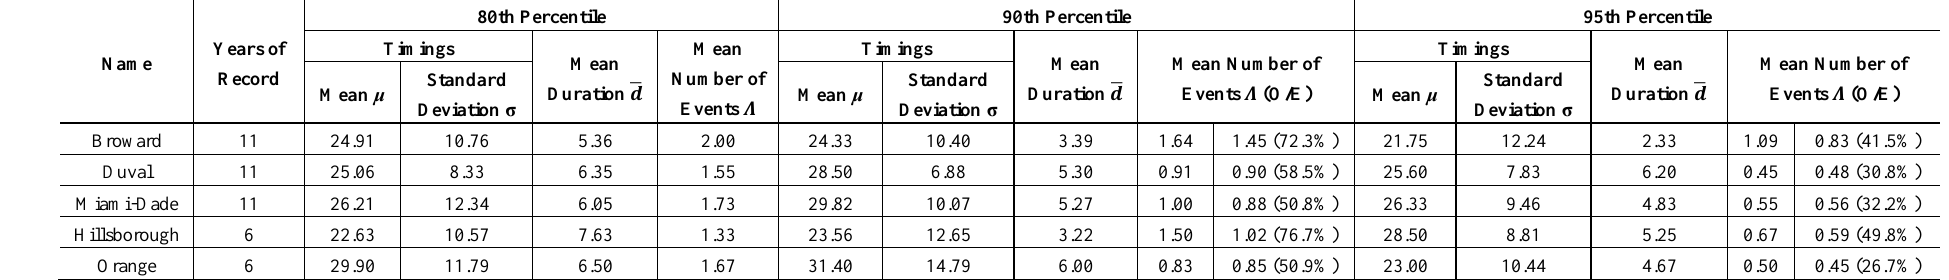
Table 1. Summary of observed and expected parameters of ILI peak events upon raising the thresholds to the 90th and 95th percentile levels (Definition 2).